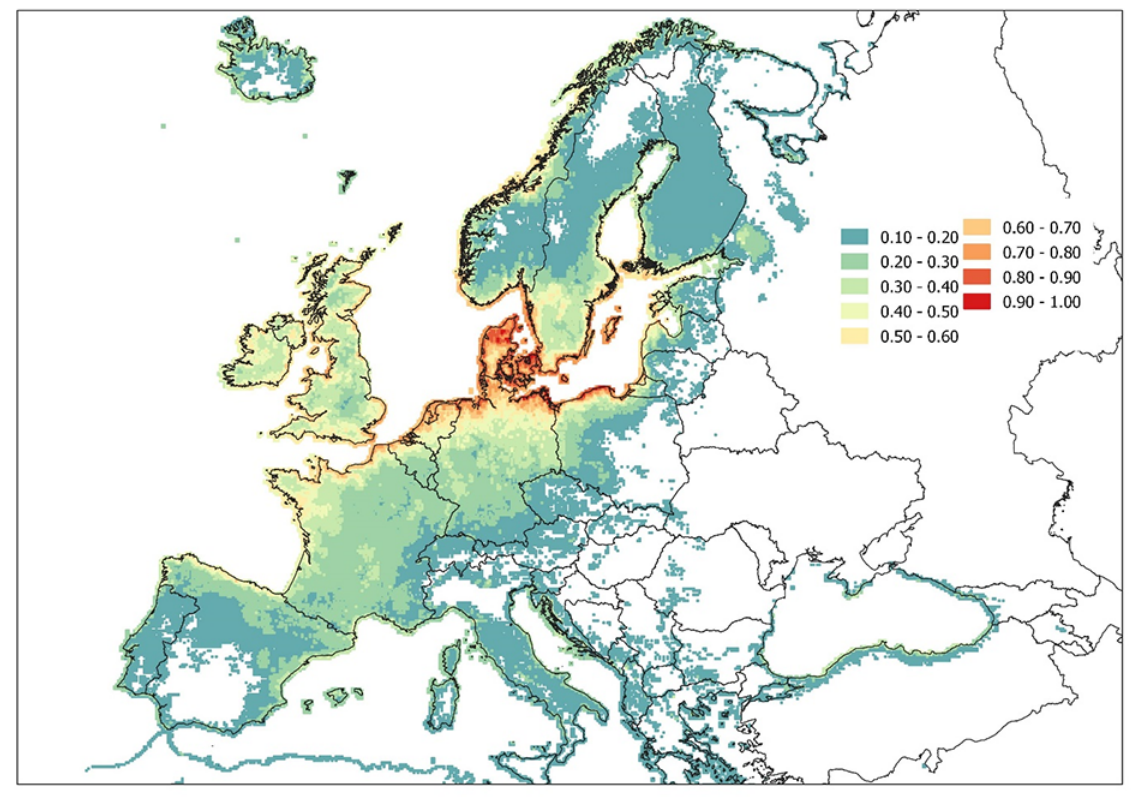
Fig. 4 Results of MaxEnt analyses: percentage (1 = 100%) of 57 species characterizing Pomerania for which the probability of occurrence